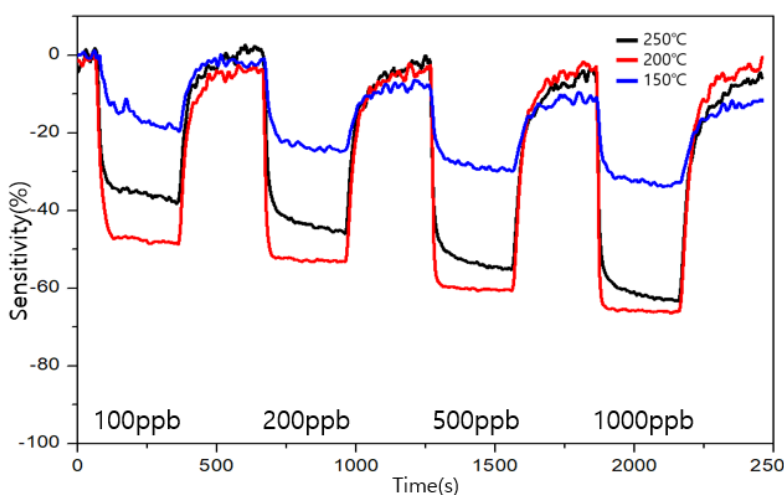
Figure 10. Sensitivity and recovery at different operating temperatures for formaldehyde in the ppb range for the type B sensor.